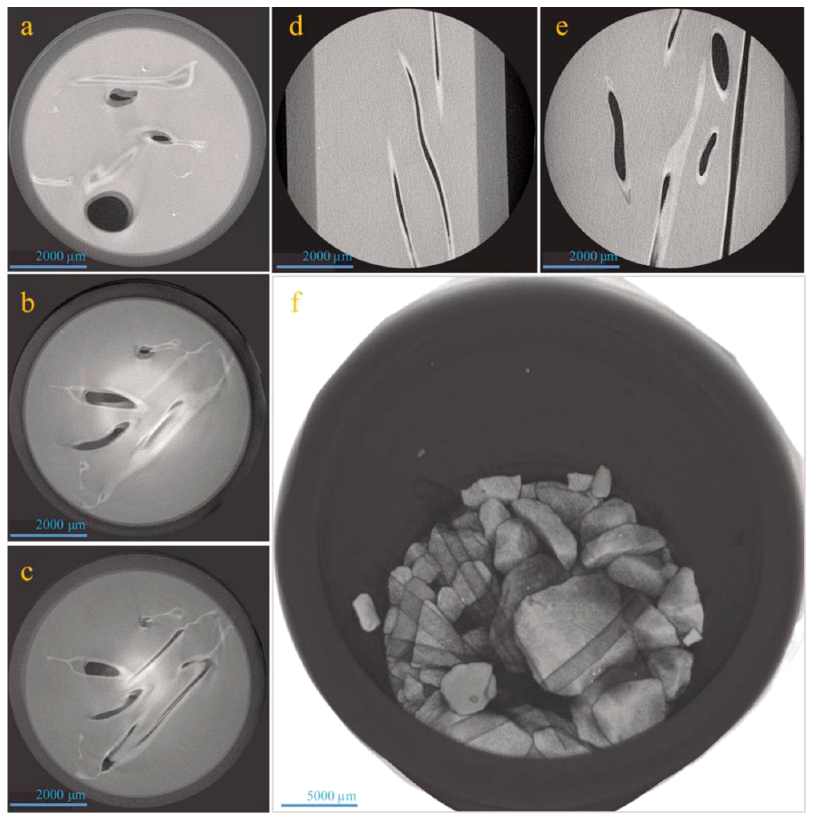
Figure 5. Micro-XCT image of microvasculars distribution in asphalts, ( a – c ) vertical view images of an asphalt sample with microvasculars, ( d , e ) side view images of an asphalt sample with microvasculars, and ( f ) 3D image of an asphalt sample with microvasculars.